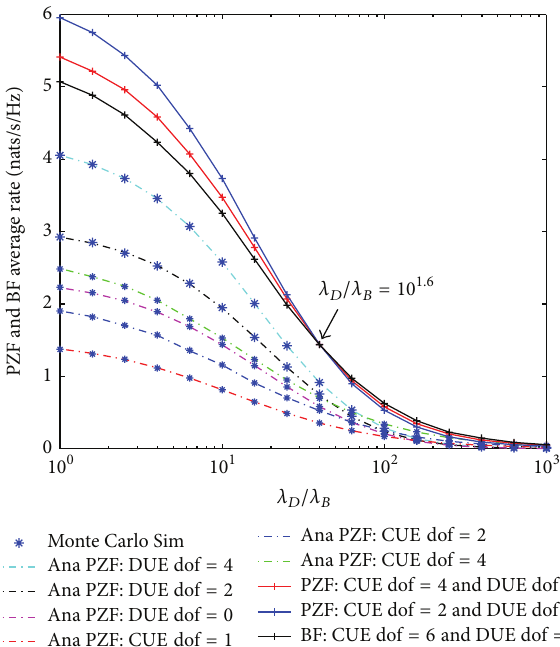
Figure 5: Average rate in PZF and BF strategies. CUE dof = 2, 4 and DUE dof = 4, 2 denote total simulation average rates include the cellular network and D2D communication in PZF